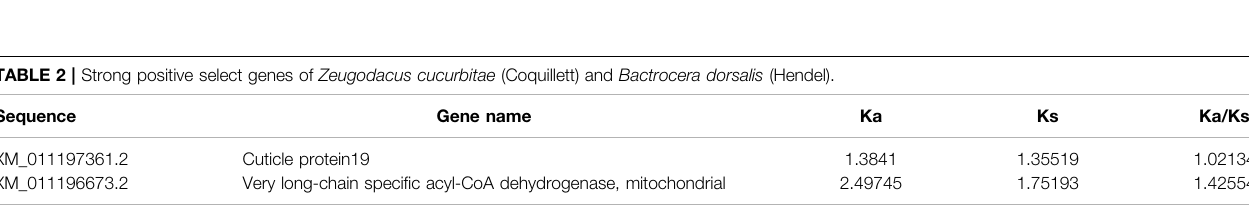
FIGURE8| ScatterplotofKa/Ksobtainedbycomparing Zeugodacuscucurbitae (Coquillett)and Bactroceradorsalis (Hendel).Note:theregionofbluespot:strong positive select genes; the region of green spot: weak positive selection genes; the region of black spot: puri fi cation selection genes.